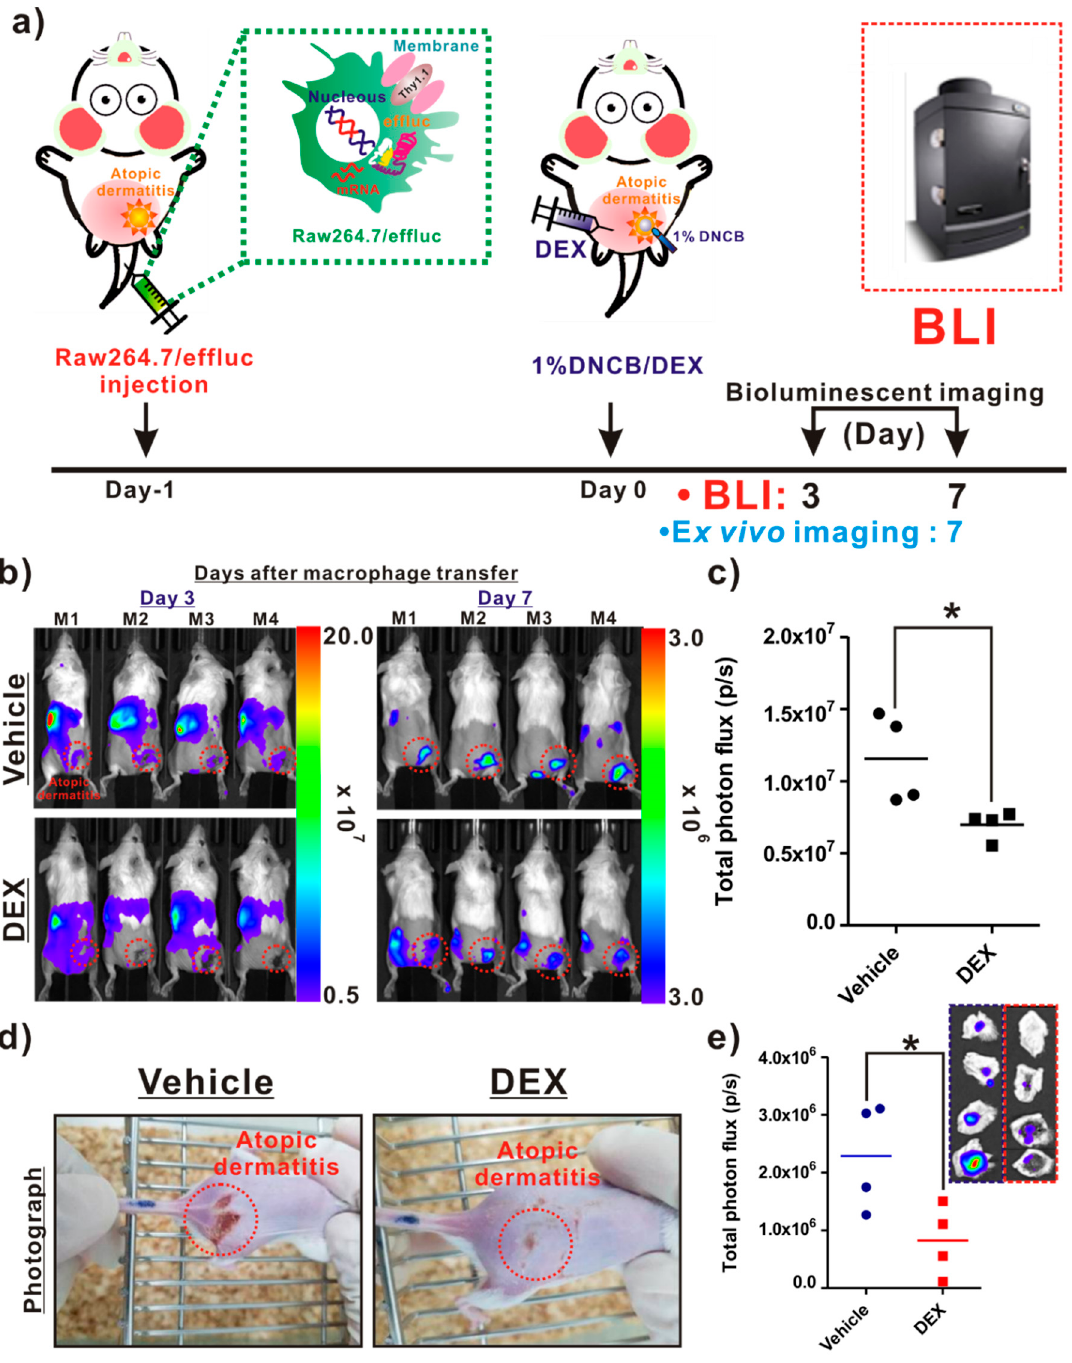
Figure 5. In vivo assessment of the therapeutic effects of an atopic dermatitis (AD)-modulating agent using the macrophage tracking approach. ( a ) Protocols for in vivo animal experiments. ( b ) In vivo optical imaging of the macrophage migration into AD-like lesions in the vehicle- and dexamethasone (DEX)-treated mice. The dotted red circles indicate the AD-like lesions. ( c ) Quantification of the bioluminescence imaging (BLI) signals (vehicle and DEX) in AD-like lesions. ( d ) Photograph of AD mice. ( e ) Quantification of the BLI signals in excised AD-like lesions from each group. Values obtained from three individual experiment are expressed as the mean ± standard deviation (SD), * p < 0.05